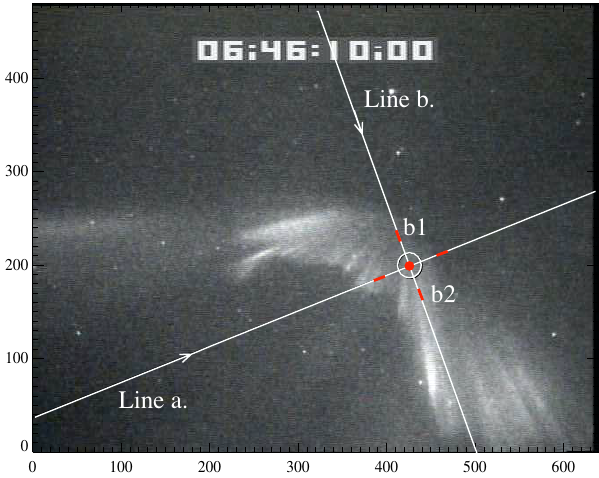
Fig. 5. An image from the camera from 06:46:10 UT, north is up- ward and east is to the left. The white circle near the center of the image corresponds to the radar beam mapped to 105km altitude. The white line (line a) corresponds to the baseline joining the two radar antennas, with the arrow indicating the positive direction. The other line is drawn 90 ◦ towards the base line. The red areas corre- sponds to regions where we have picked time series of normalised light intensity (per pixel) which has been correlated with the radar intensity time series, as shown in Fig.